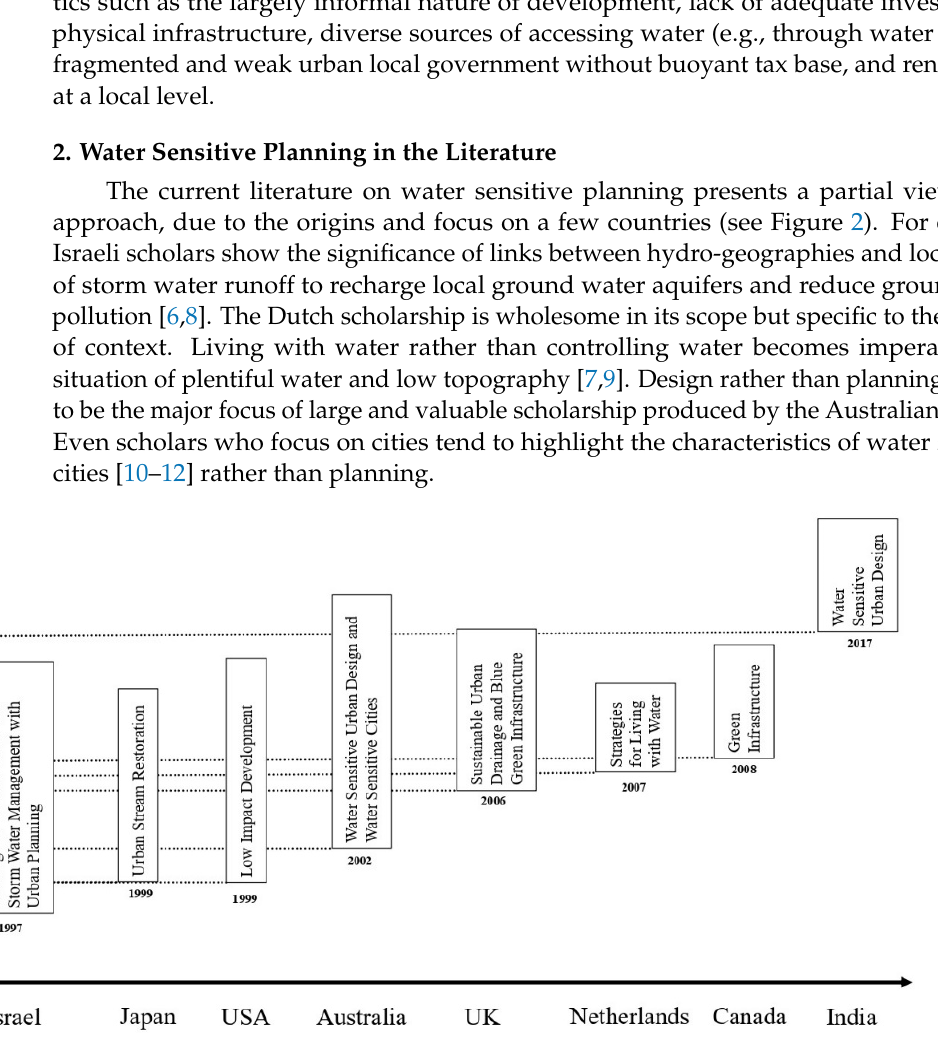
Figure 2. Development of Discourses on Water Sensitive Planning.